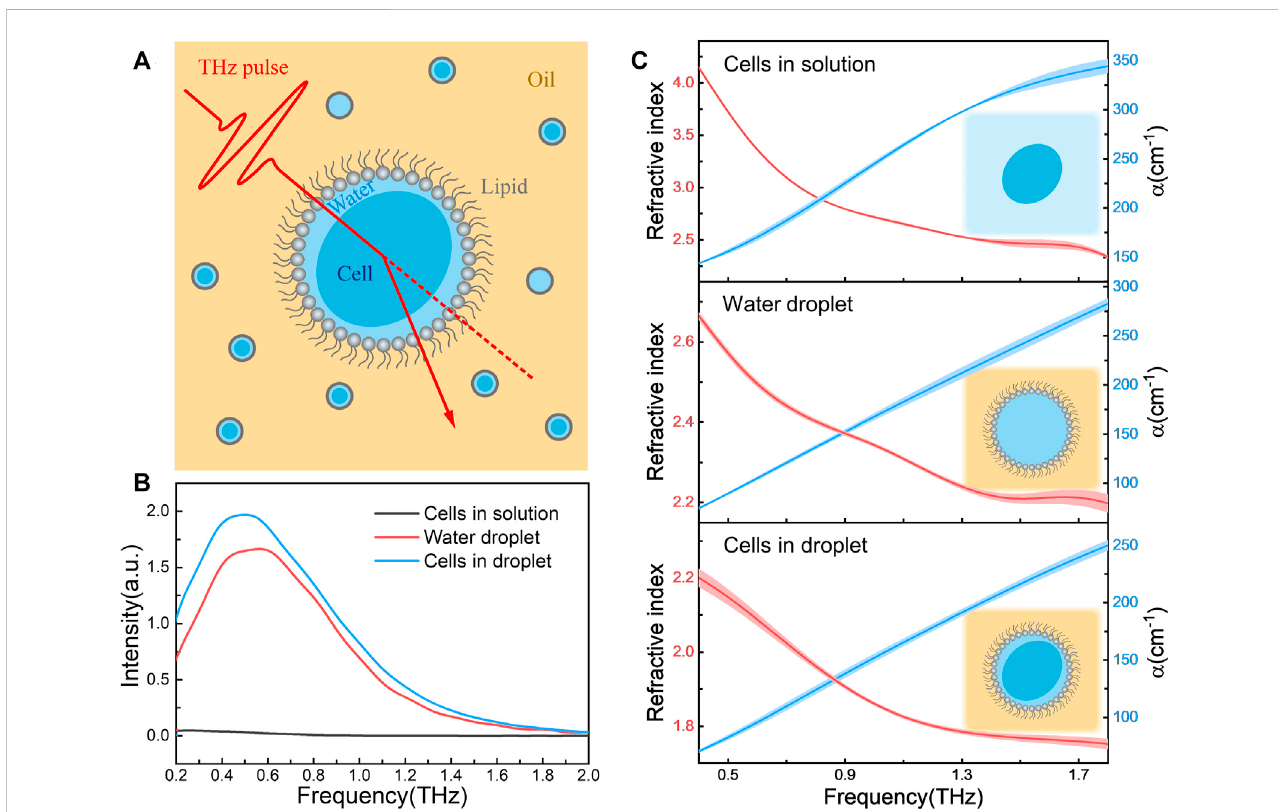
FIGURE 1 (A) Schematic of refractive index measurement platform based on the combination of terahertz spectroscopy and cellular droplet sampling. The cell- containing droplets (water phase) were dispersed in the reagent transparentto THz signals (oil phase), and the phospholipids atthe oil-water interface served as surfactants; (B) The transmission spectra of E. coli in aqueous solution (cells in solution), droplet containing TBS solution alone (water droplet) and E. coli - containing droplet (cells in droplet). All E. coli samples had the same bacterial concentration of 9.0 × 10 10 cfu/mL; (C) The refractive index (left axis) and absorptioncoef fi cient( α ,rightaxis)spectraofthesethreesamples,wheretheschematicdiagramoftheformsofsamplesareshownininsert.Theshadedarea indicating the error bars with triplicated